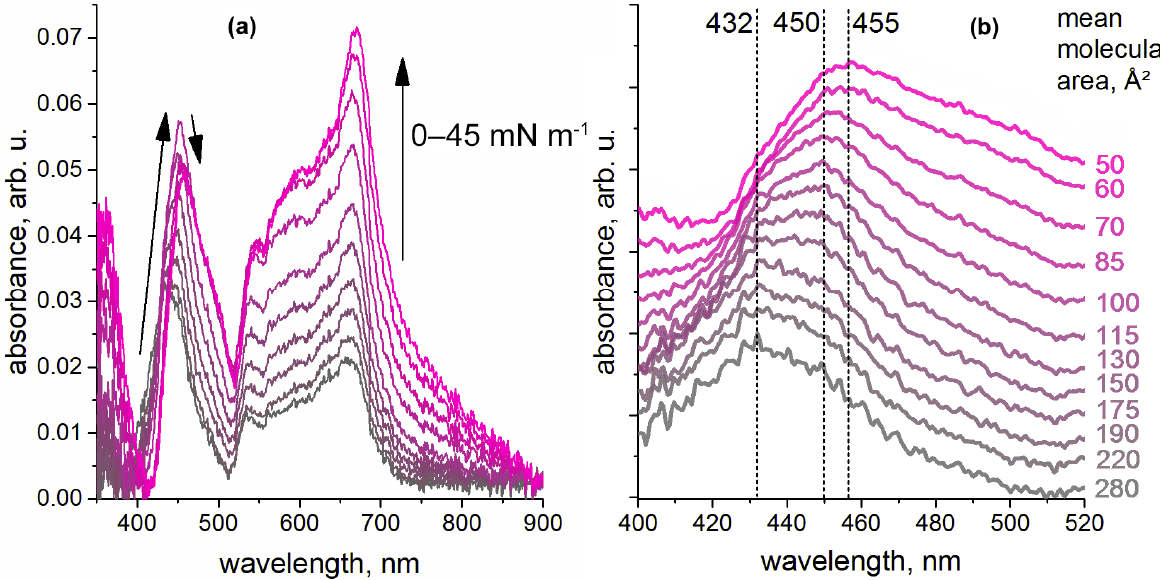
Figure 7. ( a ) Evolution of the UV-vis spectra of the NiTPP × CRPcRu(pyz) 2 mixed monolayer upon its lateral compression; ( b ) Detailed view of the NiTPP Soret band: the spectra were normalized [0;1] and are presented here with a y -axis shift of 0.1 after each subsequent spectrum for clarity. Numbers to the right provide the mean molecular area values corresponding to the spectra.